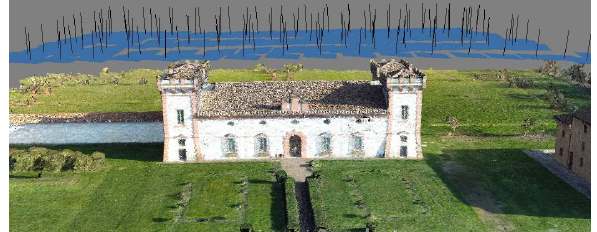
Figure 17: Point clouds and camera positions obtained using